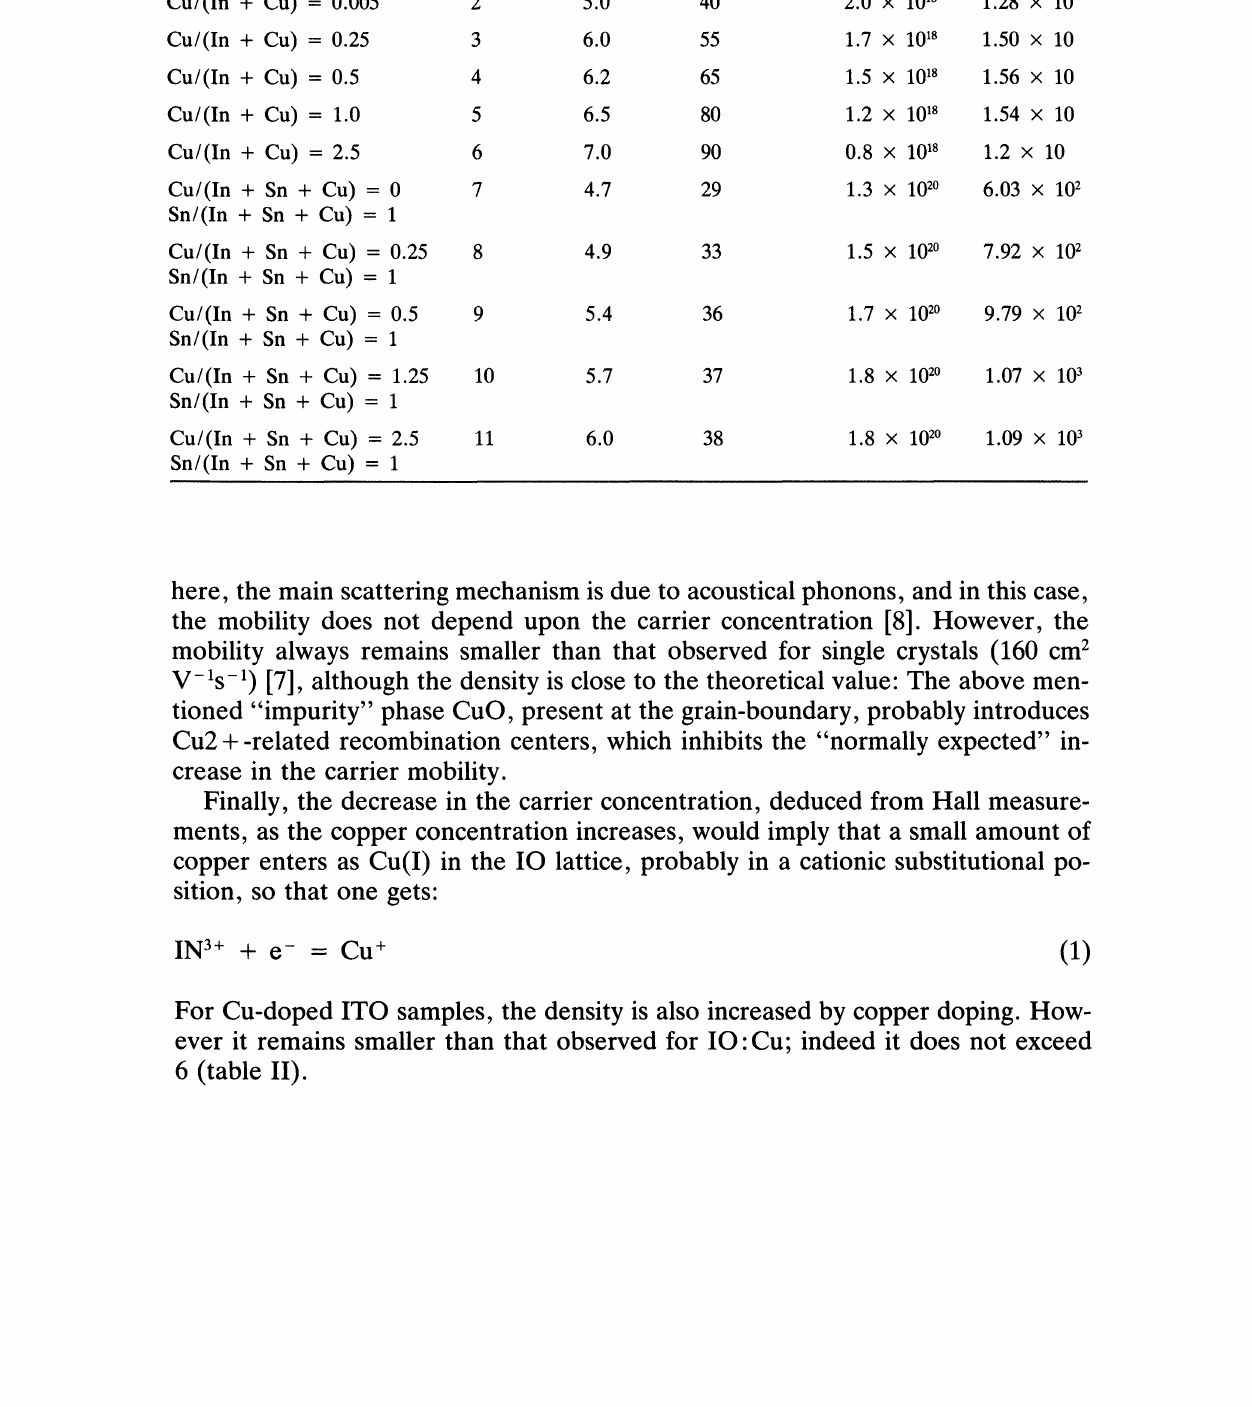
Value of Cu doping concentrations in IO and ITO based ceramics; corresponding densities and values of the main electrical parameters. Starting material